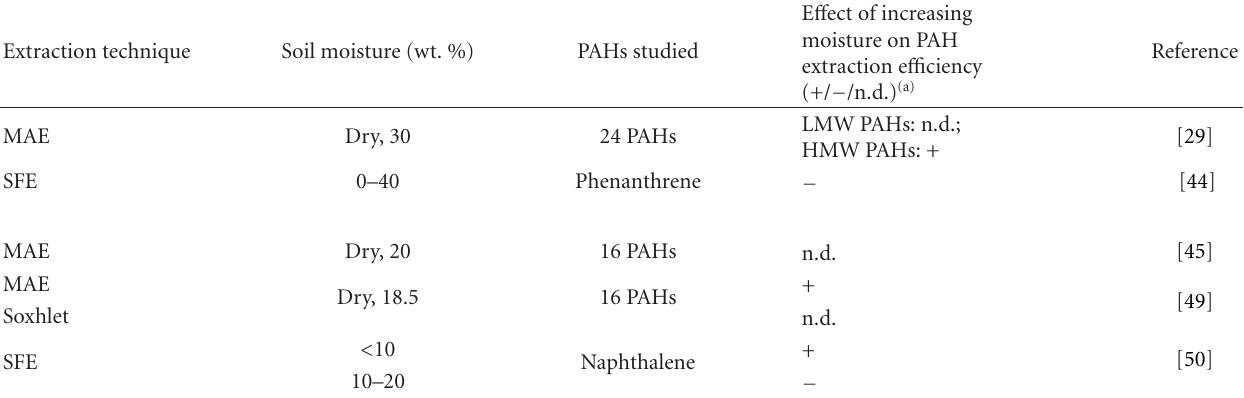
Table 3: Bibliographic compilation of studies on soil moisture.